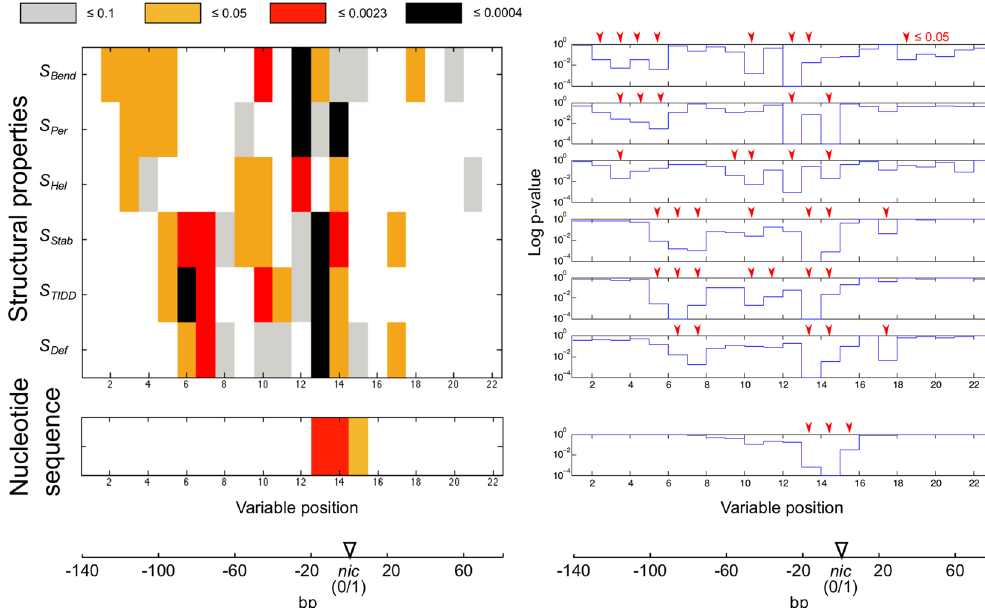
Figure 3. Conservation of structural variables and nucleotide sequences according to analysis of variance. Variables of 6 structural properties and nucleotide sequences in windows of 10 bp were compared at 22 positions in oriT regions (labeled ‘Variable position’ on the x axis). P values of the F statistic (y axis) are given at levels of significance that are (i) uncorrected (0.05) and (ii) corrected for multiple comparisons within a particular structural property or nucleotide sequence spanning 22 variables (0.0023) or (iii) whole set of 6 structural properties